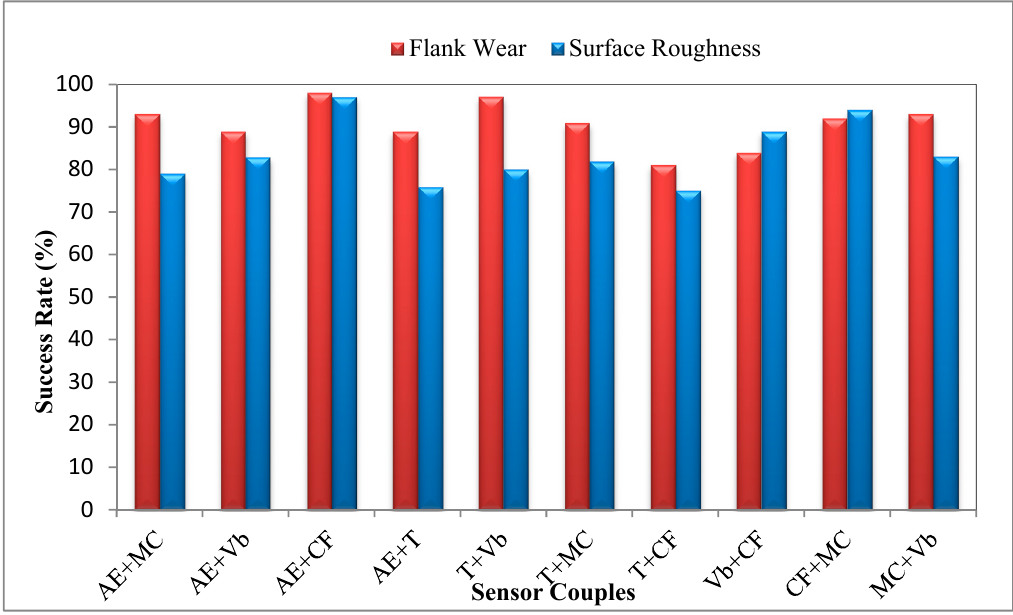
Figure 5. Success Rate of Sensor Couples for Flank Wear and Surface Roughness. Sensors 2020 , 20 , x FOR PEER REVIEW